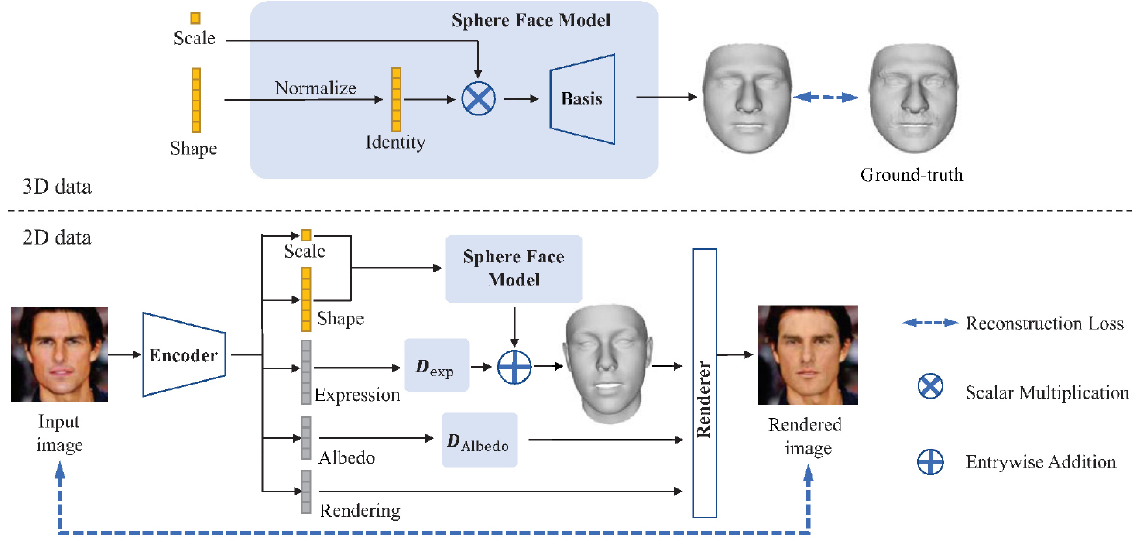
Fig. 2 Framework of our method. The normalization of x generates the identity parameters distributing on a hypersphere. The normalized identity parameter is multiplied by the scale parameter to get the shape parameter and goes through the basis to get the corresponding mesh. When training on 3D data, we directly optimize s and x . When training on 2D data, we use encoder–decoder because it requires other parameters to render the